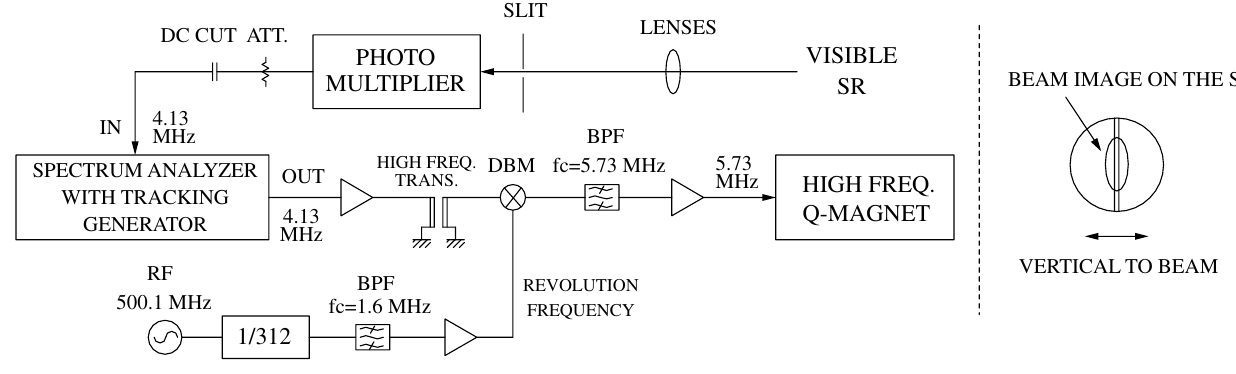
FIG. 4. Setup for measuring the vertical quadrupolar